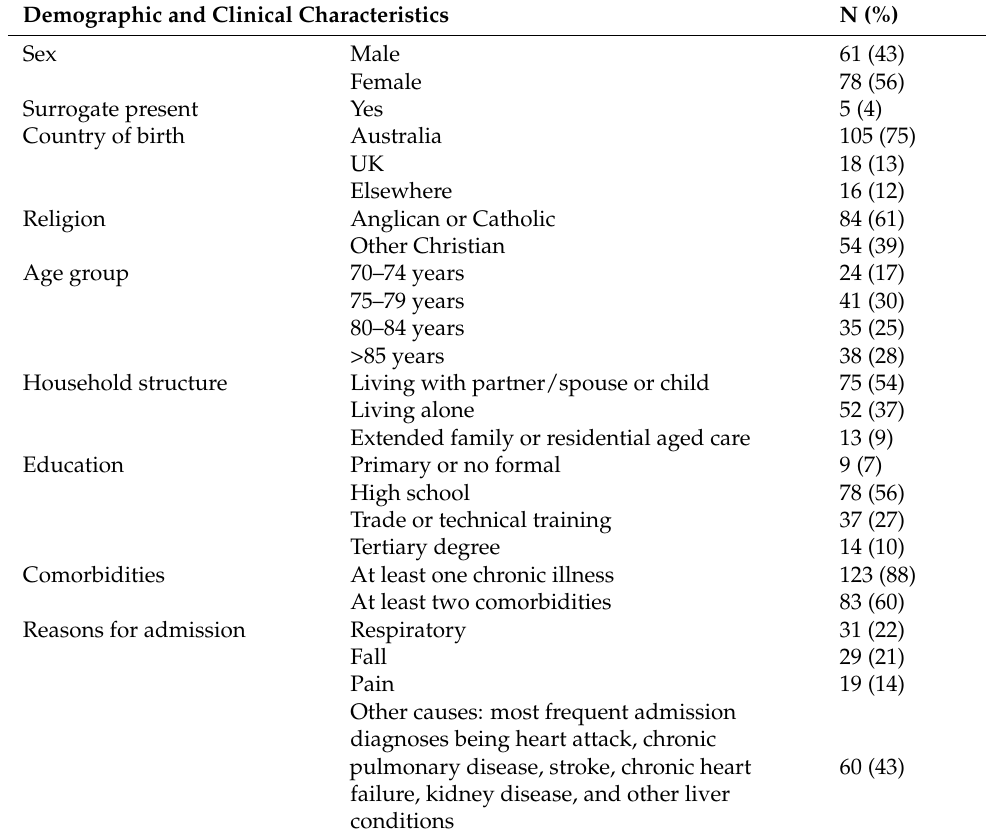
Table 1. Participant characteristics (N =